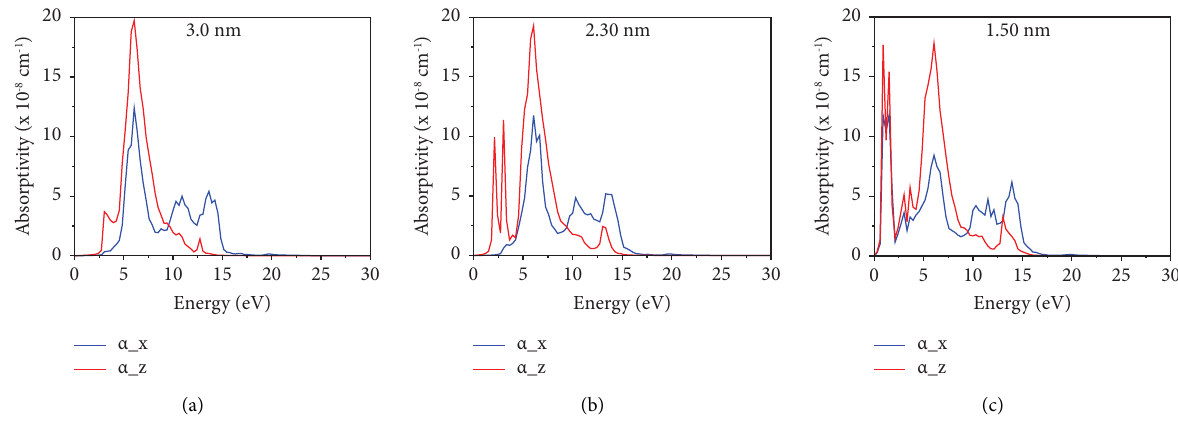
Figure 14: Optical absorptions for armchair CBNNT under diferent